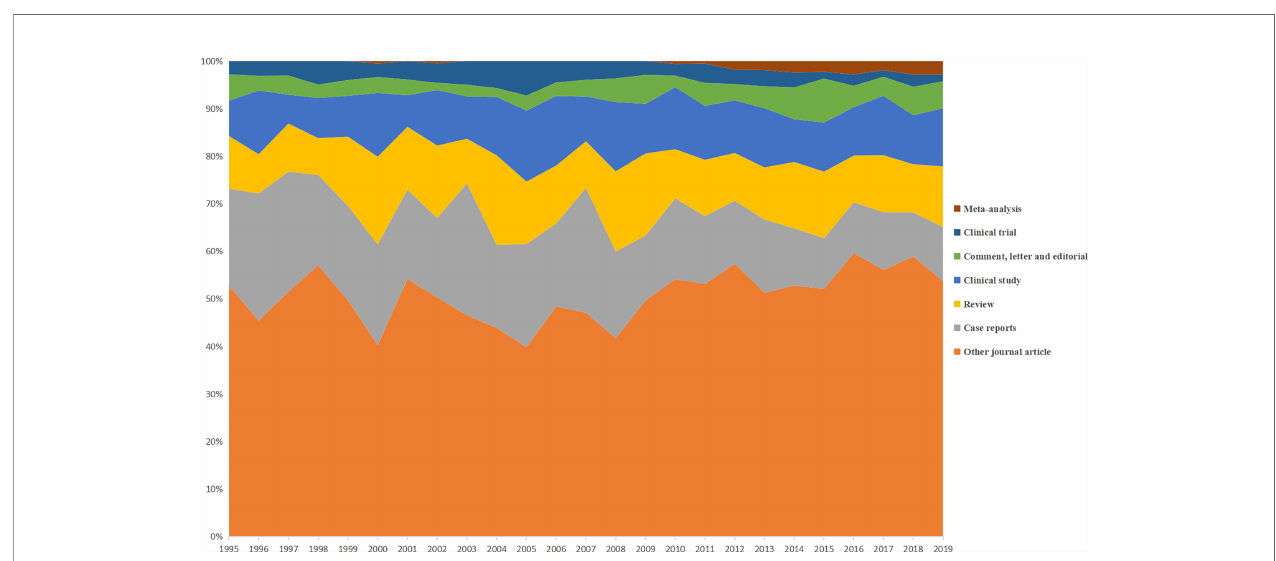
FIGURE 2 | Distribution of publication types per year.